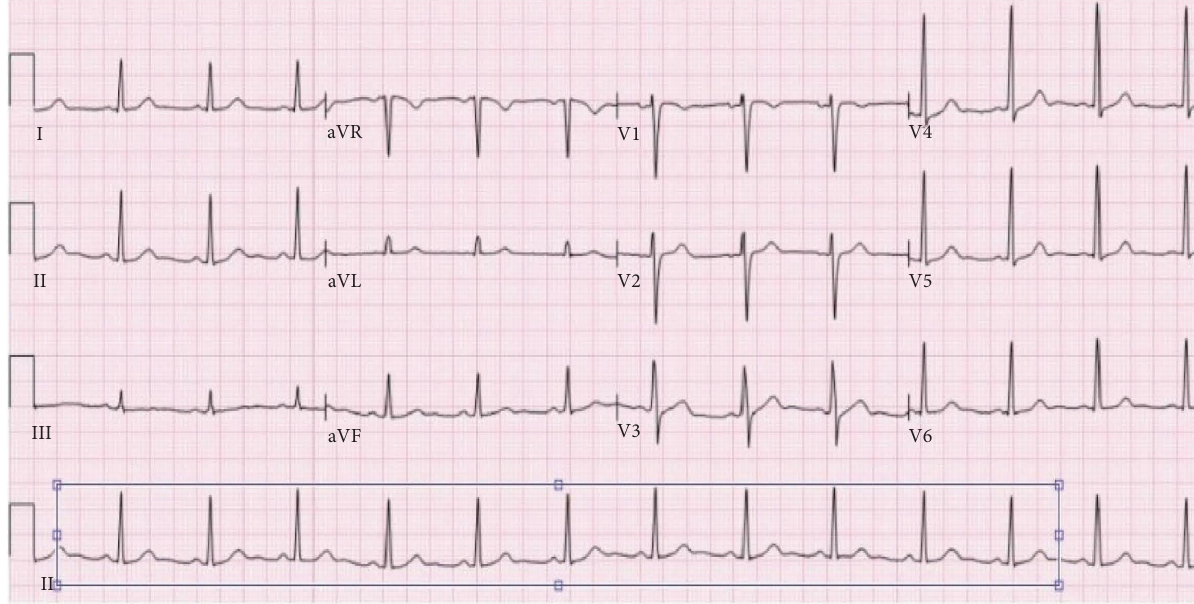
Figure 3: Original ECG image.